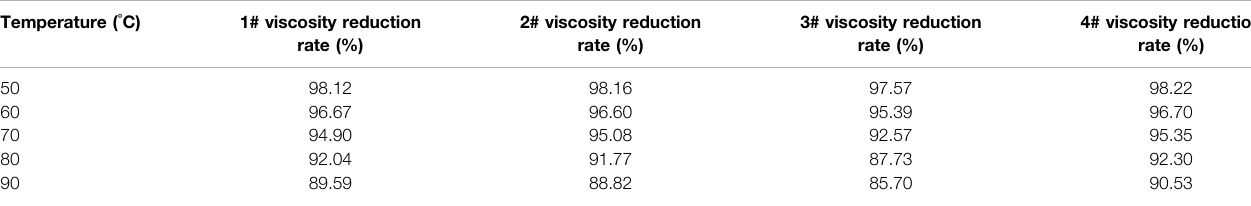
TABLE 4 | Experimental data of viscosity reduction rate. Temperature ( °